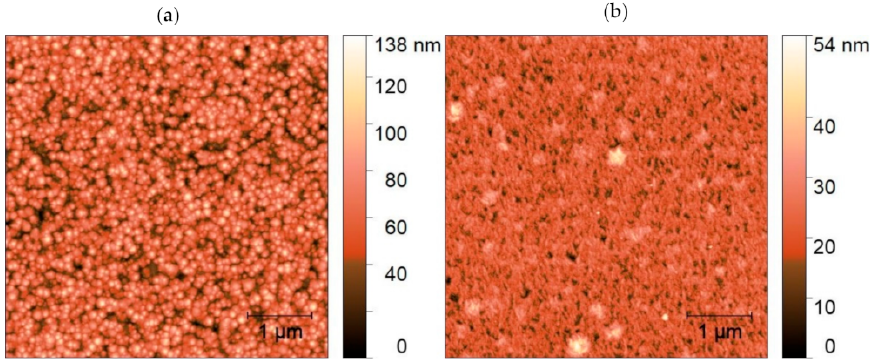
Figure 4. AFM surface images of ZnO:Eu thin film ( a ) as deposited and ( b ) after PLA processing, 800